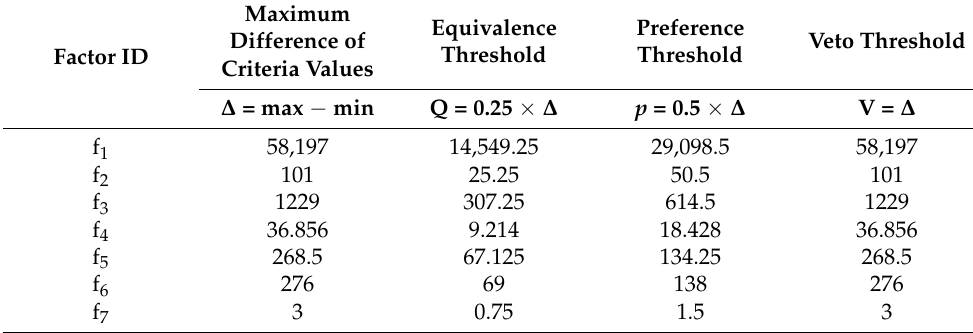
Table 5. Values of the equivalence, preference, and veto thresholds in light of the considered criteria.